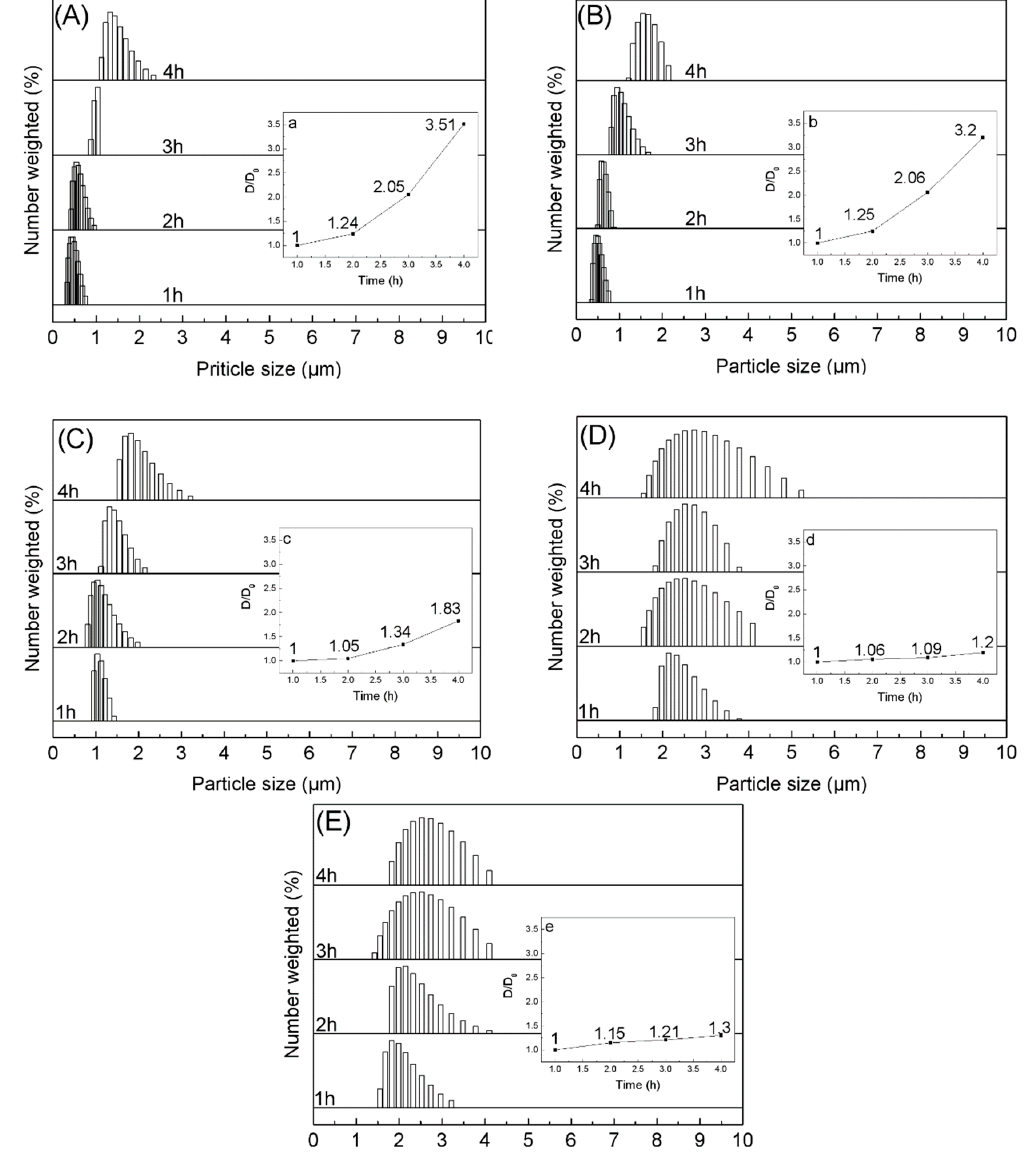
Figure 6. Dependence of emulsion size on the reaction stirring time for emulsifying system with